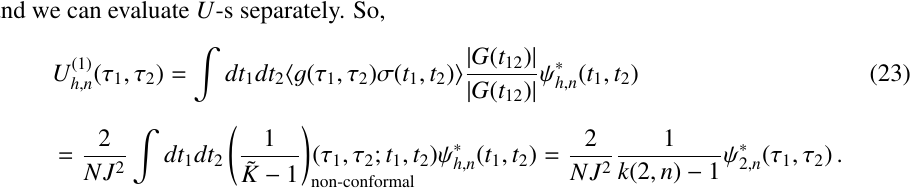
Figure 5: Cutting the 3-point function. The shaded stripes represent the external